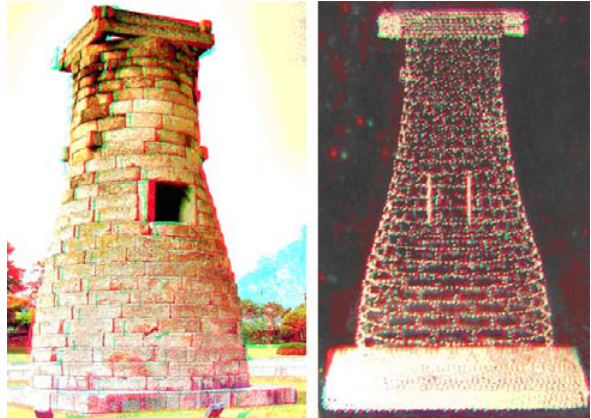
Figure 6. Color anaglyphs of a recent 3D photography of the ancient Cheomseongdae observatory in Gyeongju (Republic of Korea/South Korea) in comparison with a “zero generation” lasered crystal of the same object (photographs by the authors, use color anaglyph glasses!) Figure 6 (left), possibly showing the world eldest observatory in South Korea, is a typical 3D photography taken (very fast) under “expedition constraints”, while the sample in Figure 7